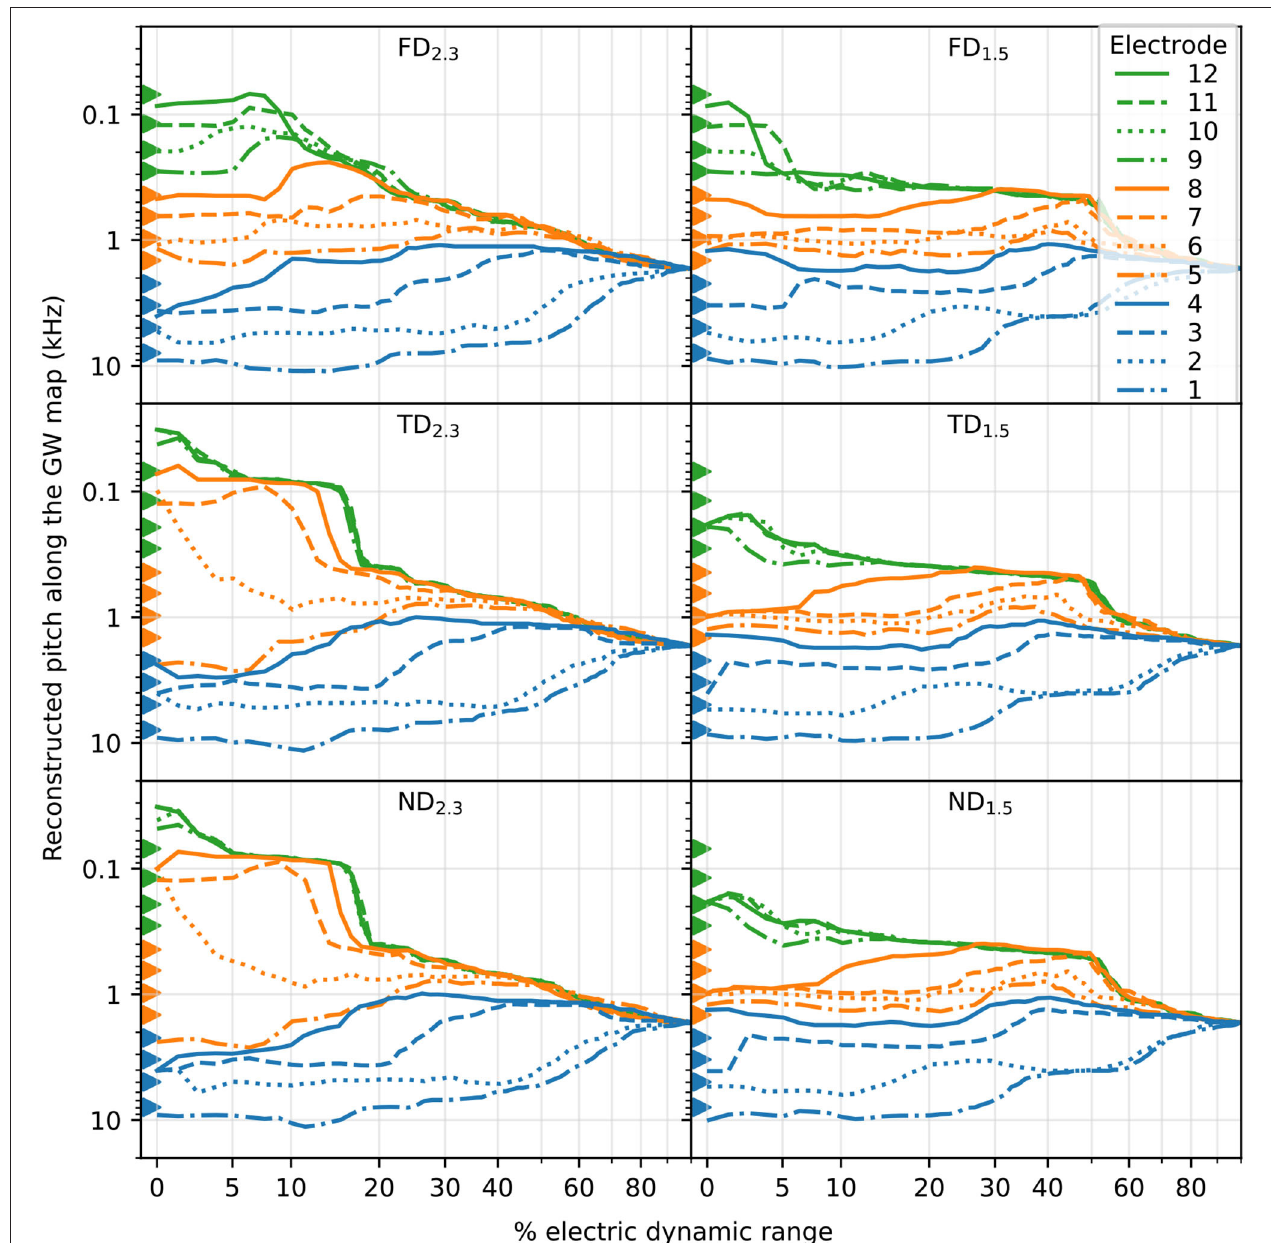
FIGURE 10 | The reconstructed pitch along % of EDR. Pitch reconstruction was based on the centroid of the excited area and the Greenwood map. Basal, middle, and apical electrode stimulations are marked by color, and individual electrodes are marked by line style. Electrode position, corresponding to the pitch of its nearest fiber, is marked with